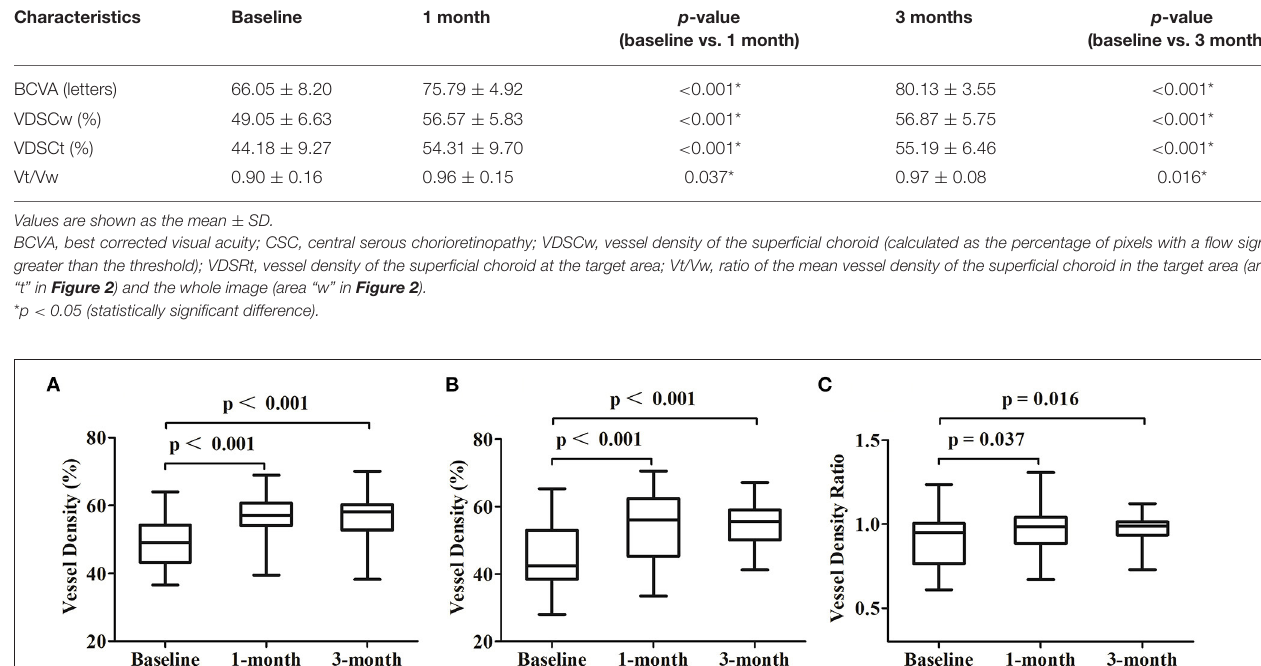
TABLE 2 | BCVA and vessel density of the superficial choroidal capillaries of CSC patients. Characteristics